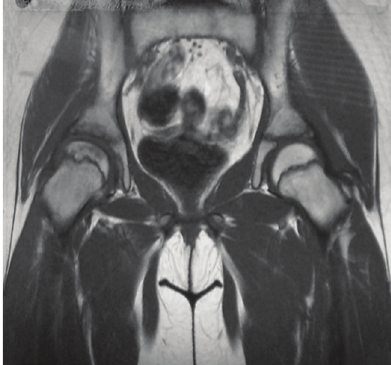
Figure 4: Boundary line of the necrosis of the capital of the femur with a fat-like aspect, good remodelling of the femoral head, and morphologic normalization of the physes are shown in this follow up